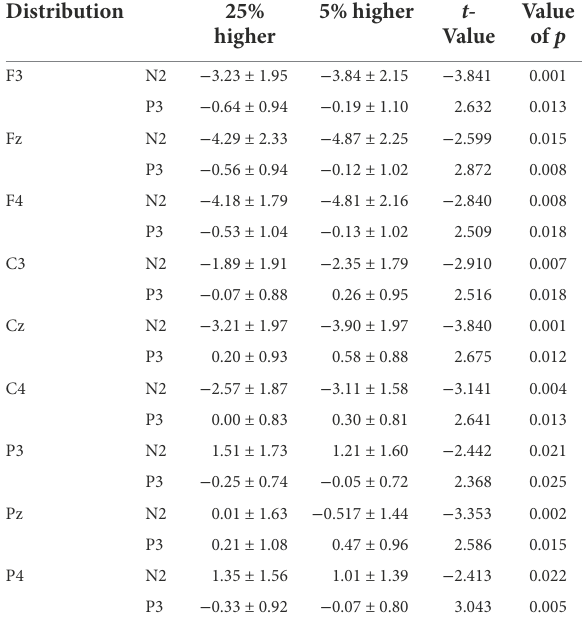
TABLE 1 The basic descriptive statistics of evoked.